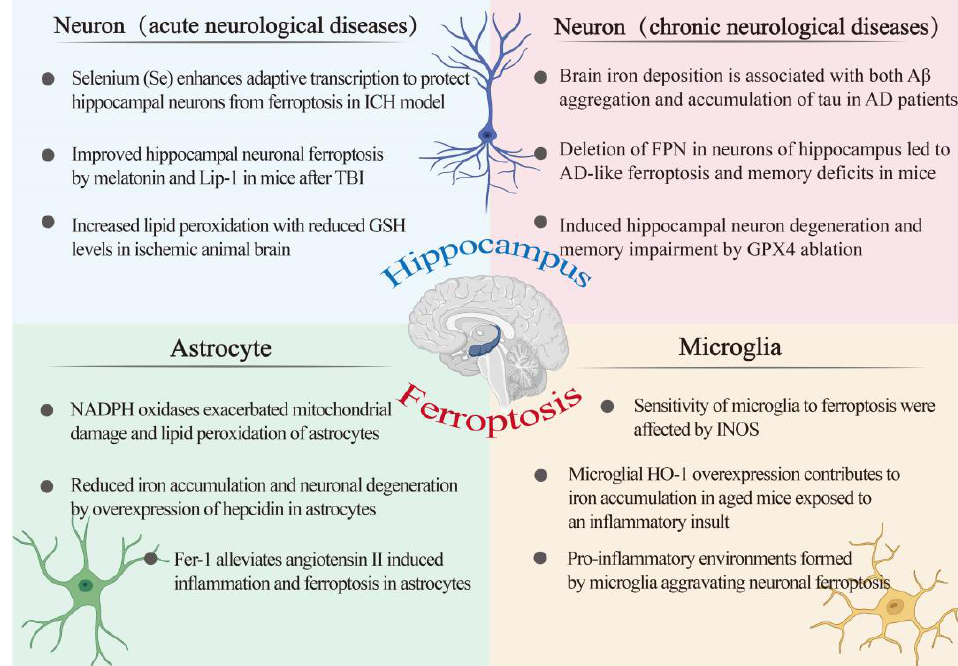
Figure 3. An overview of the ferroptosis-associated mechanism in hippocampal-related diseases. The relationship between the hippocampus and ferroptosis was investigated from the perspective of three cell types, namely, astrocytes, microglia, and neurons. Neurons are divided into acute central nervous system disease and chronic central nervous system disease. AD: Alzheimer’s disease; FPN: ferroportin; Fer-1: ferrostatin-1; GSH: glutathione; GPX4: glutathione peroxidase 4; HO-1: heme oxygenase-1; INOS: inducible nitric oxide synthase; ICH: intracerebral hemorrhage; Lip-1: liproxstatin-1; Se: selenium; TBI: traumatic brain injury.